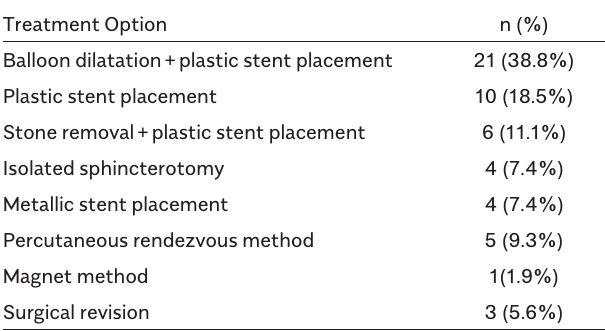
Table 2. Treatment Modalities in Patients with Biliary Complications Treatment